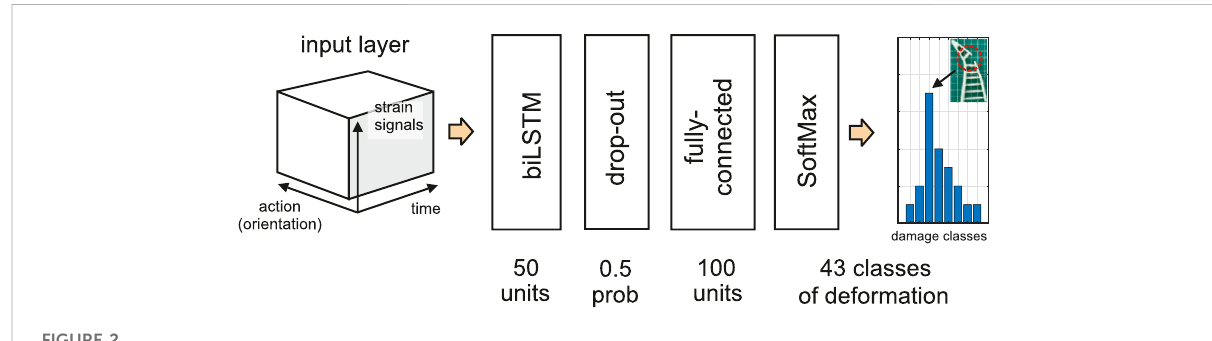
FIGURE 2 Architecture of the proposed damage detection/localization